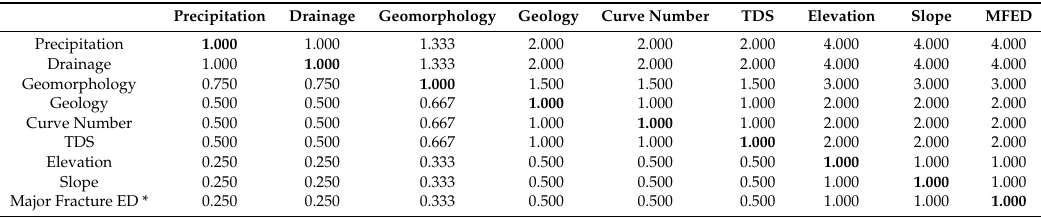
Table 3. Pairwise Comparison